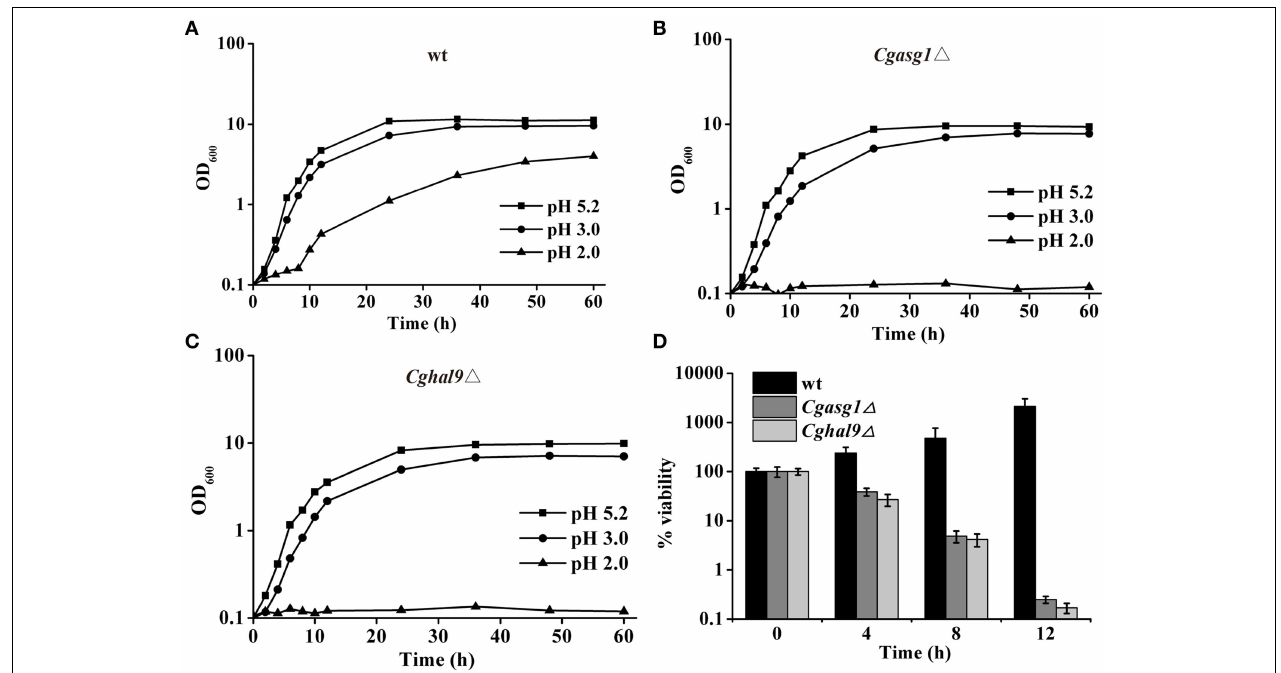
the Cgasg1 1 and Cghal9 1 strains in an acidic environment. Data are expressed as the percentages of viability of each strain relative to that of the control (time point 0) in YNB medium. The means and standard deviations for three independent experiments are shown.